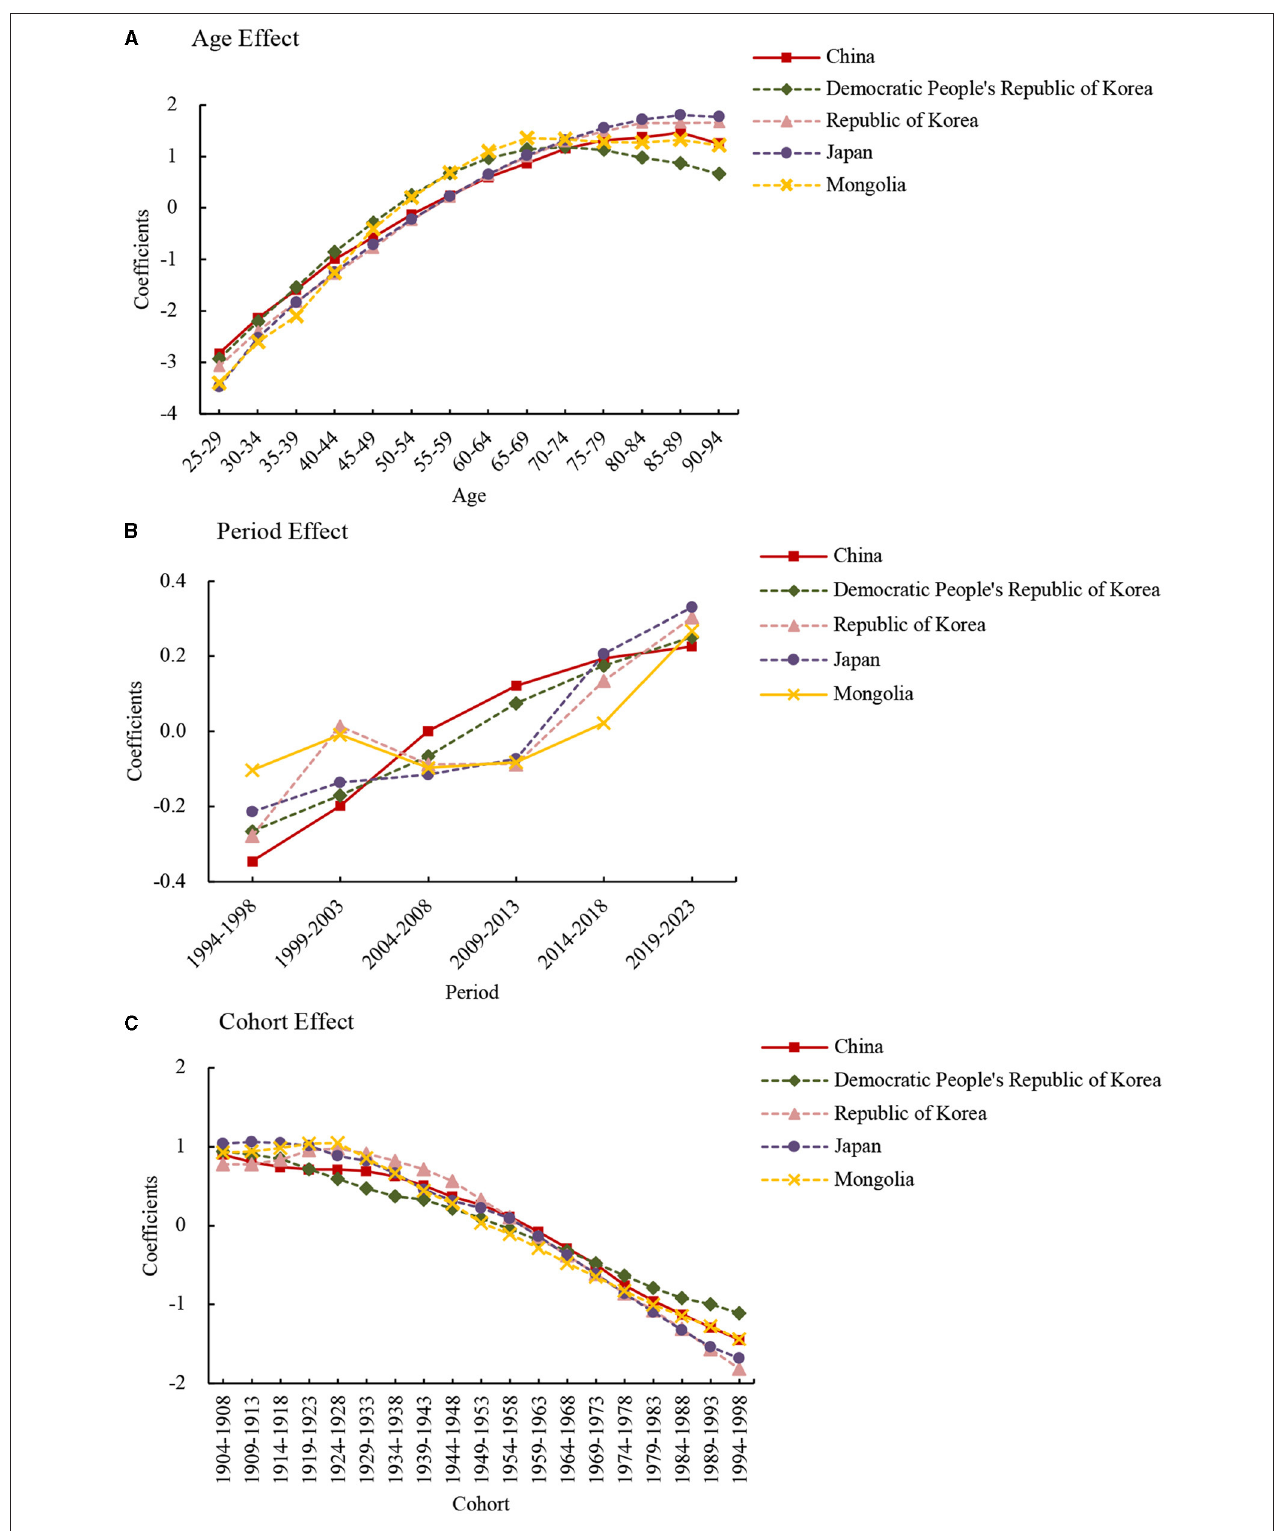
FIGURE 2 | Lung cancer death attributable to PM 2.5 estimated coefficients for the age (A) , period (B) , and cohort effects (C) .